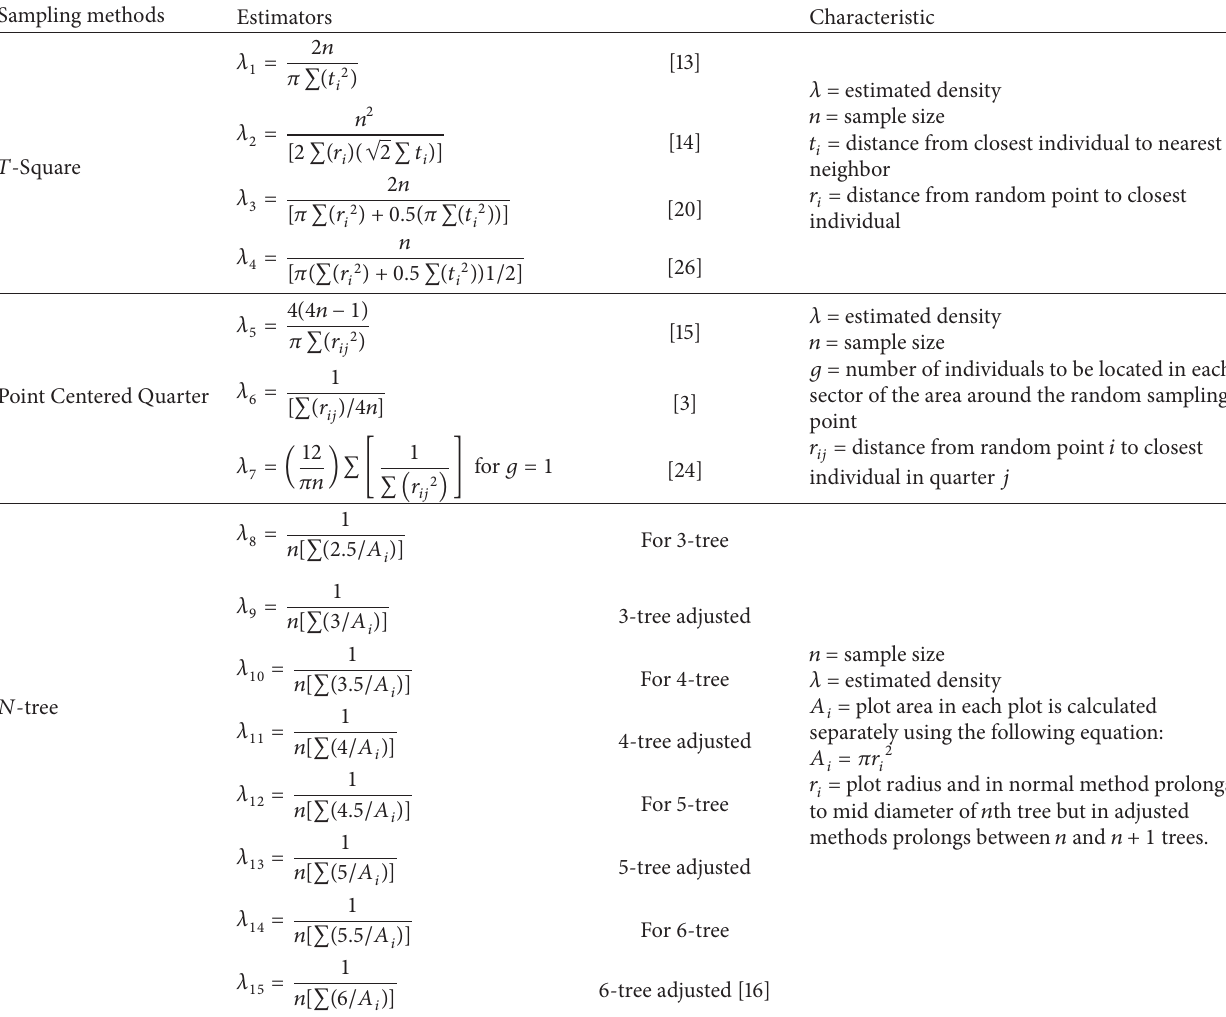
Table 2: Different sampling methods and estimators used in this study (adapted from